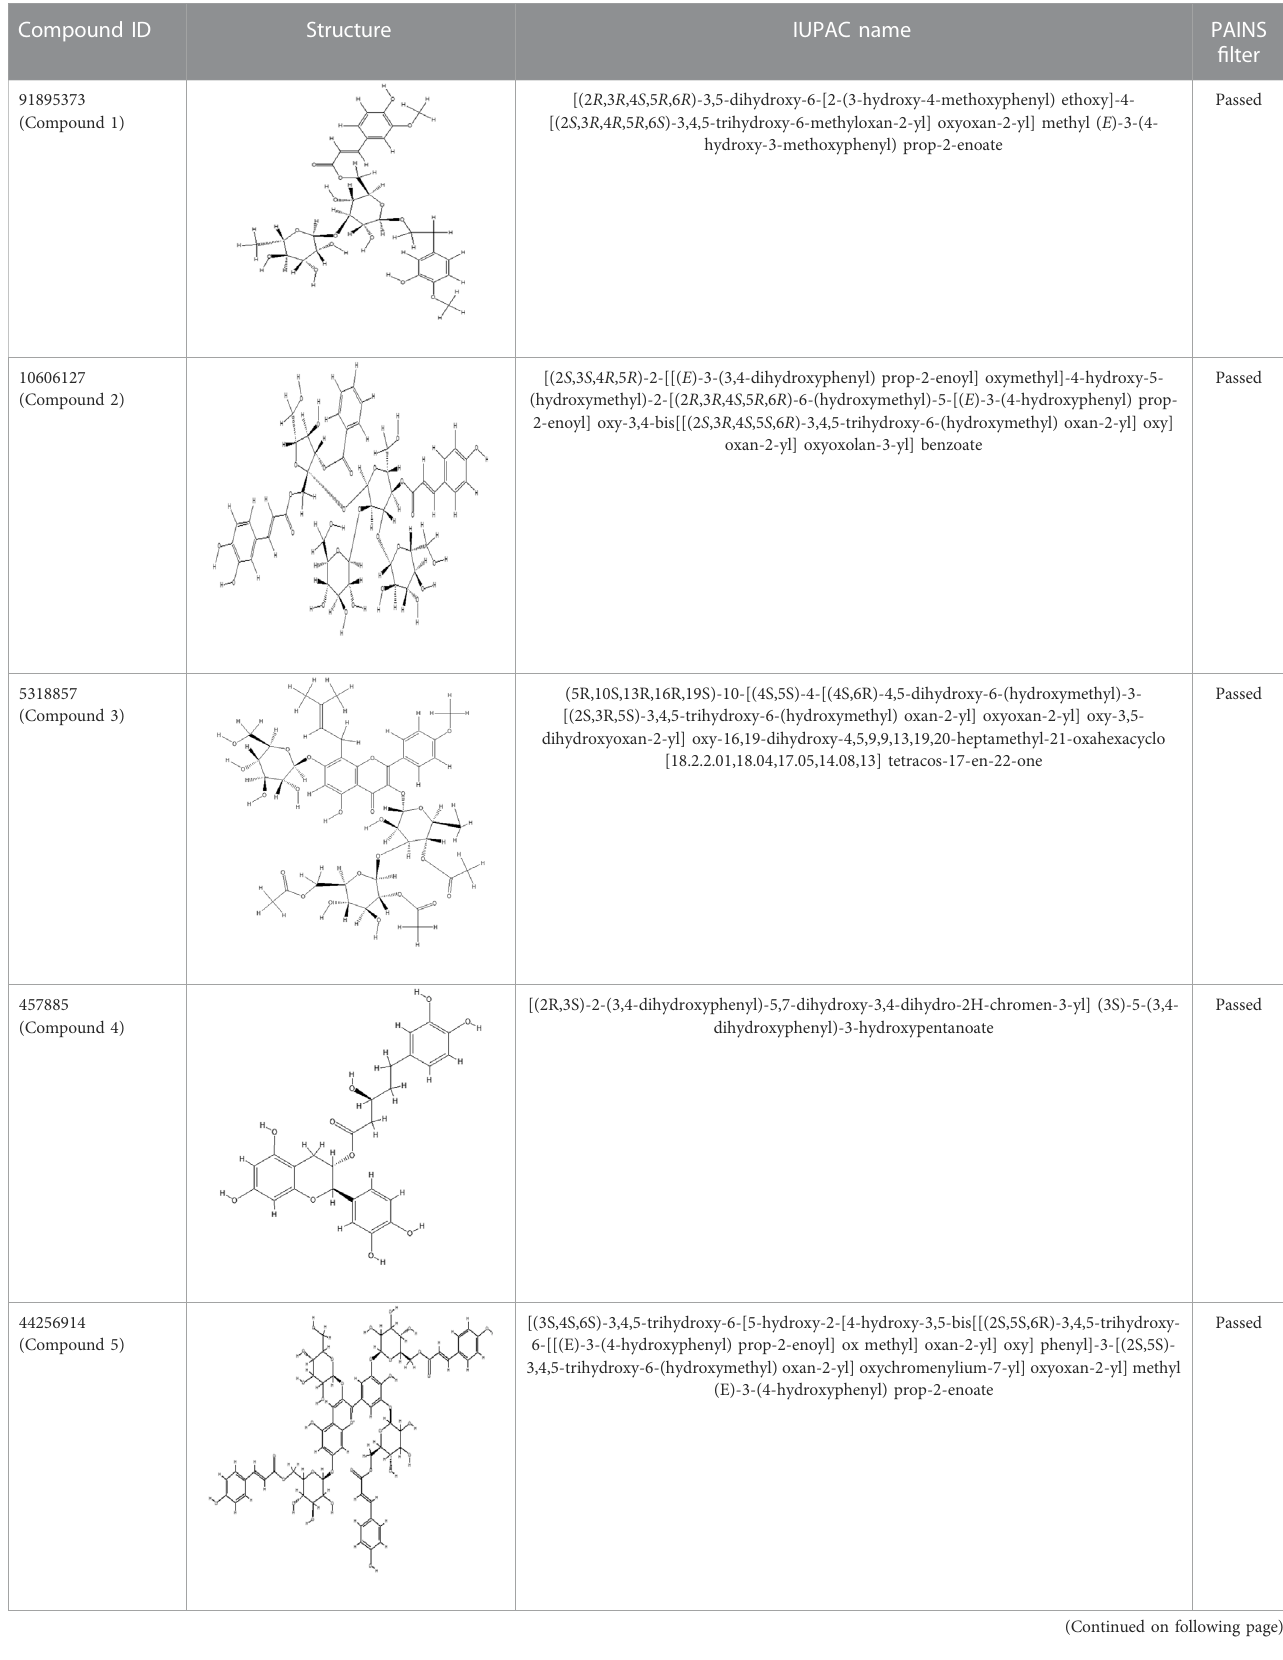
TABLE 4 PubChem ID of the compound, IUPAC name of compound and the PAIN fi lter result of the compounds. Compound